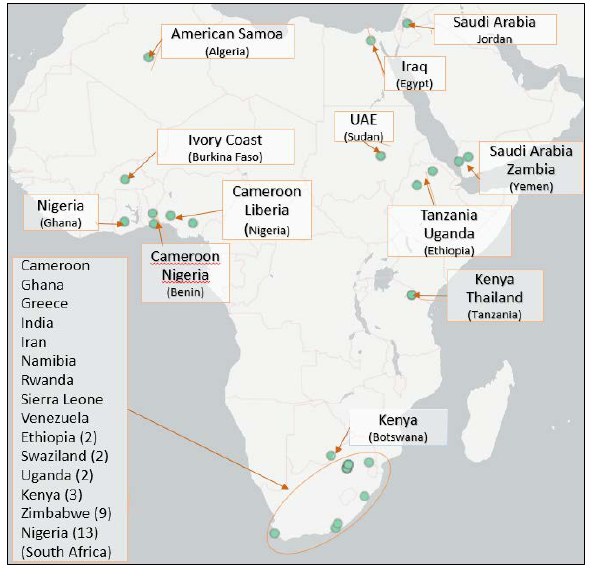
Figure 8: Birth country of author where it differed to country of residence (country of submission in brackets).